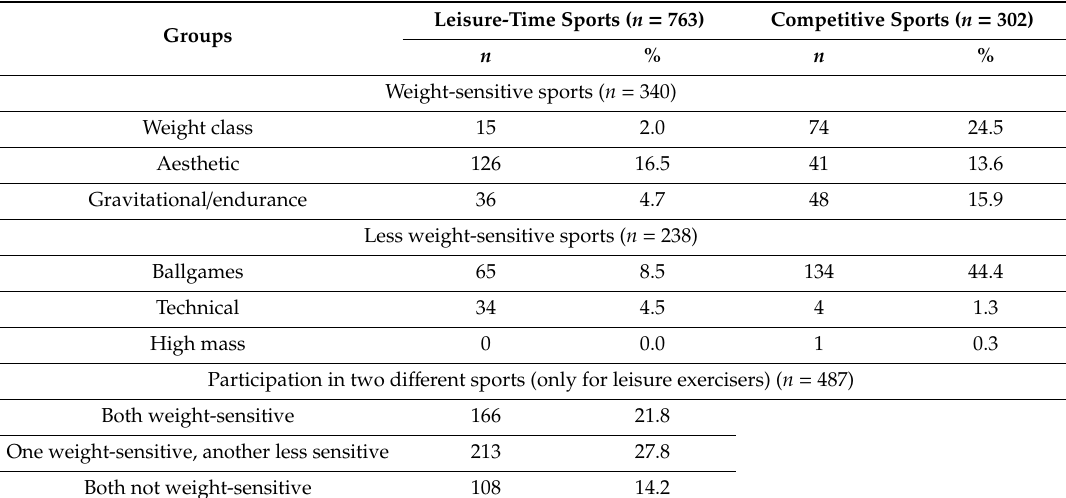
Table A1. Distribution of the leisure-time and competitive sports participants in di ff erent weight-sensitive and less weight-sensitive